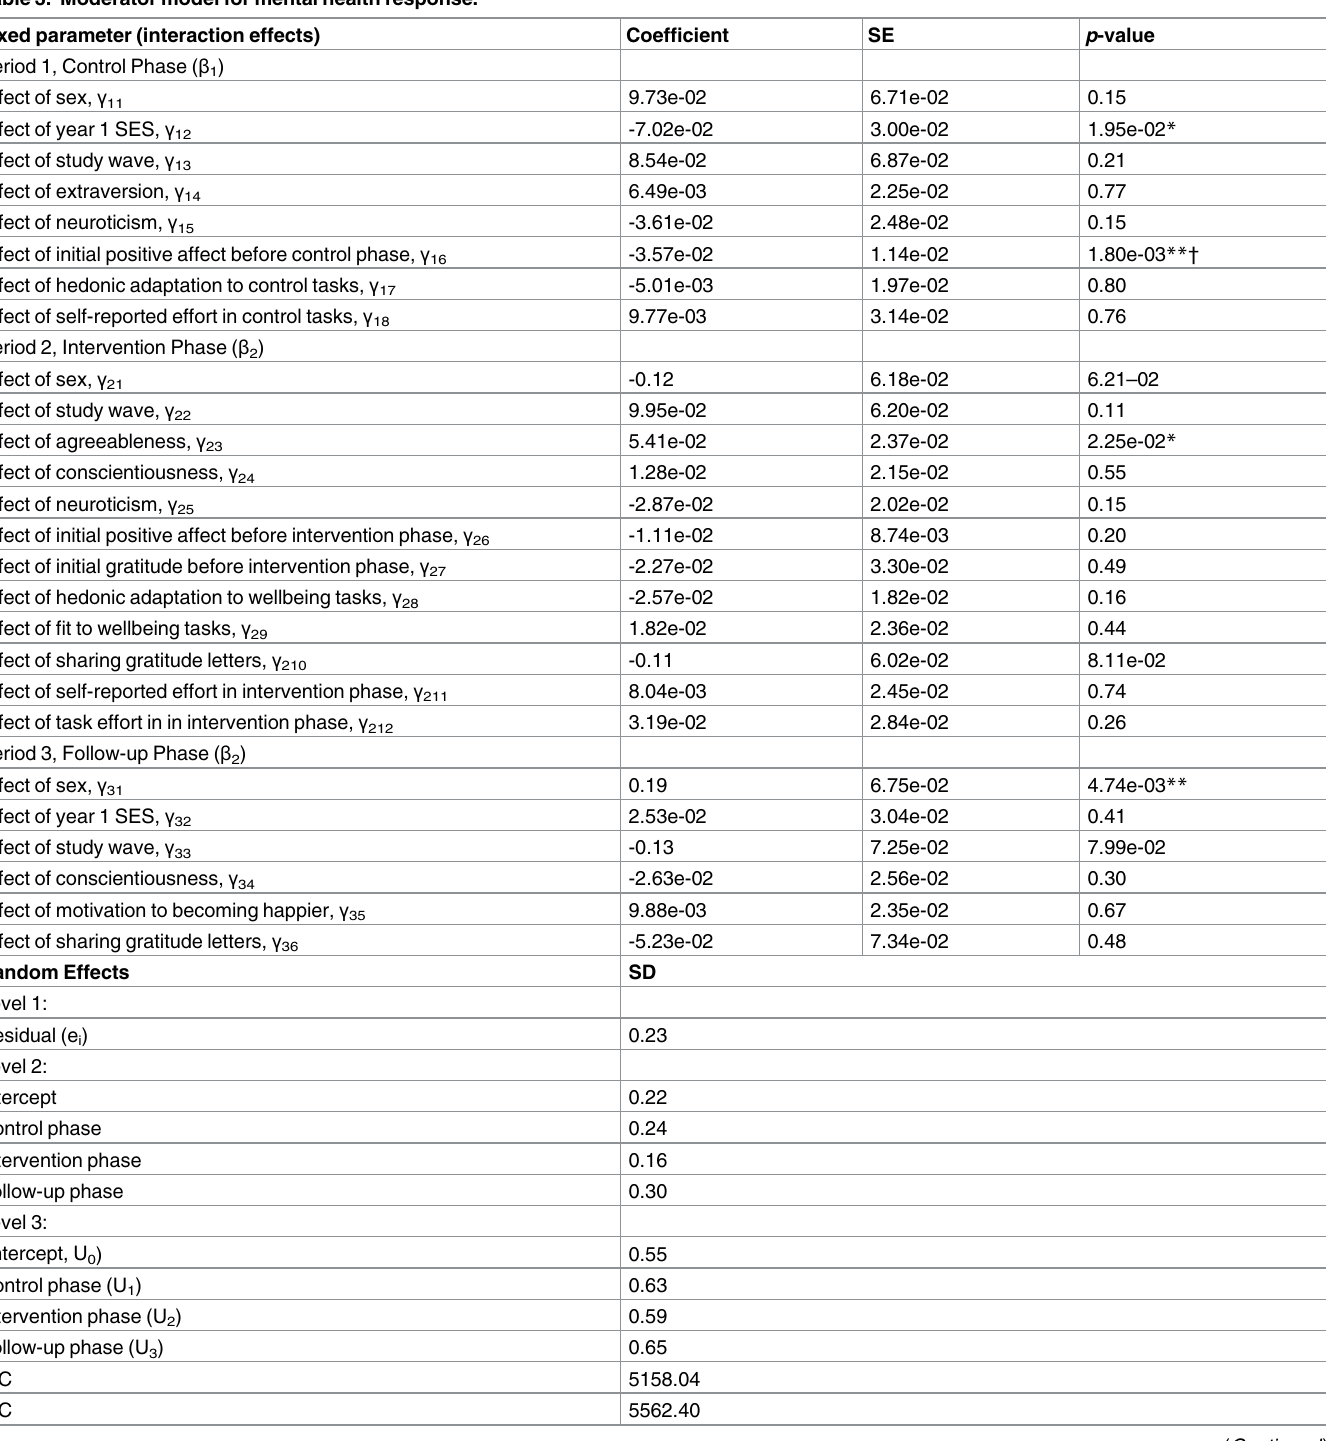
Table 3. Moderator model for mental health